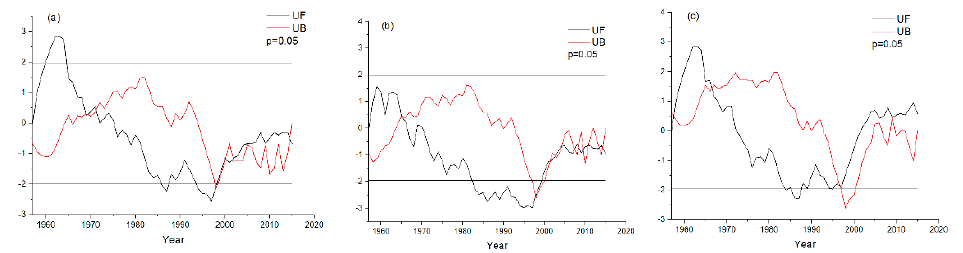
Figure 9. The streamflow change point of the ( a ) nugesha, ( b ) nuxia, and ( c ) yangcun stations in